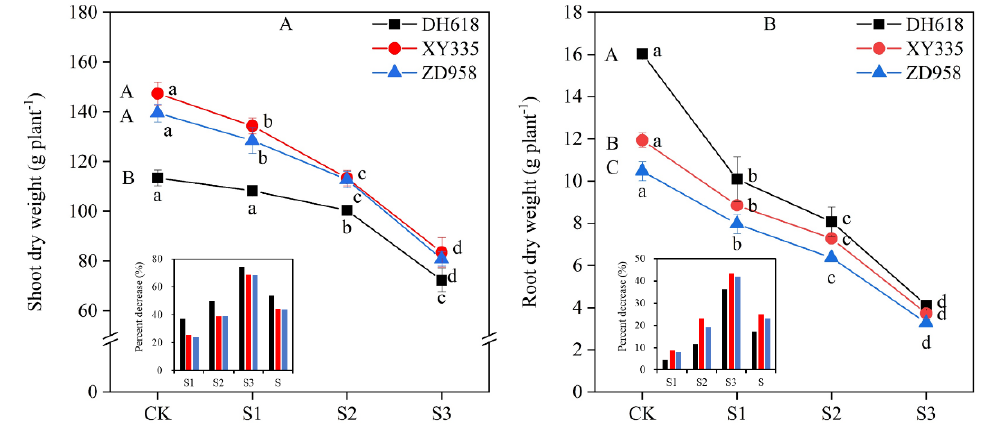
Figure 7. Maize shoot dry weight and root dry weight of different cultivars under different shading levels by averaging two densities. ( A ): Shoot dry weight; ( B ): Root dry weight. The bars represented the error standard ( n = 24). Analysis of variance was used to compare the differences of CK, S1, S2 and S3 among different cultivars. No shared lowercase letters indicate significant differences between treatments at p < 0.05.